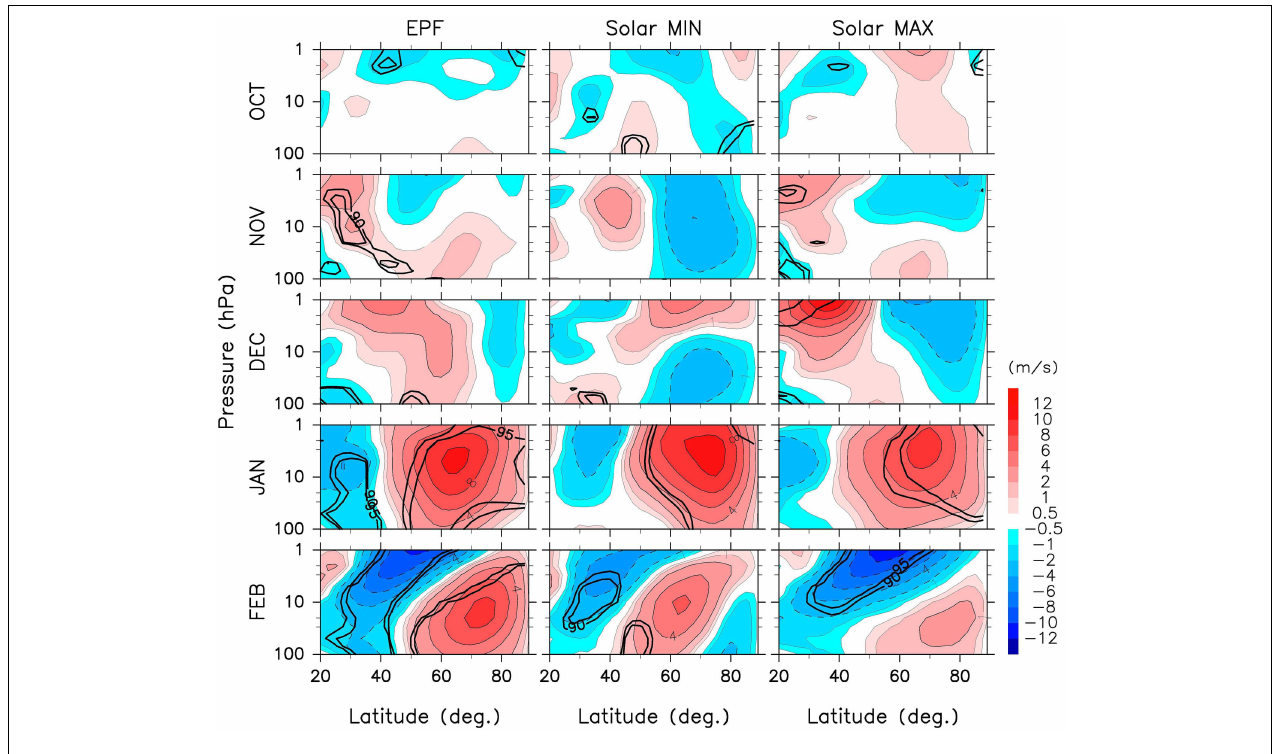
FIGURE 1 | Latitude–pressure sections of monthly- and zonal-mean zonal wind anomalies from October through February in the northern hemisphere for high EPF (left), solar minimum (middle), and solar